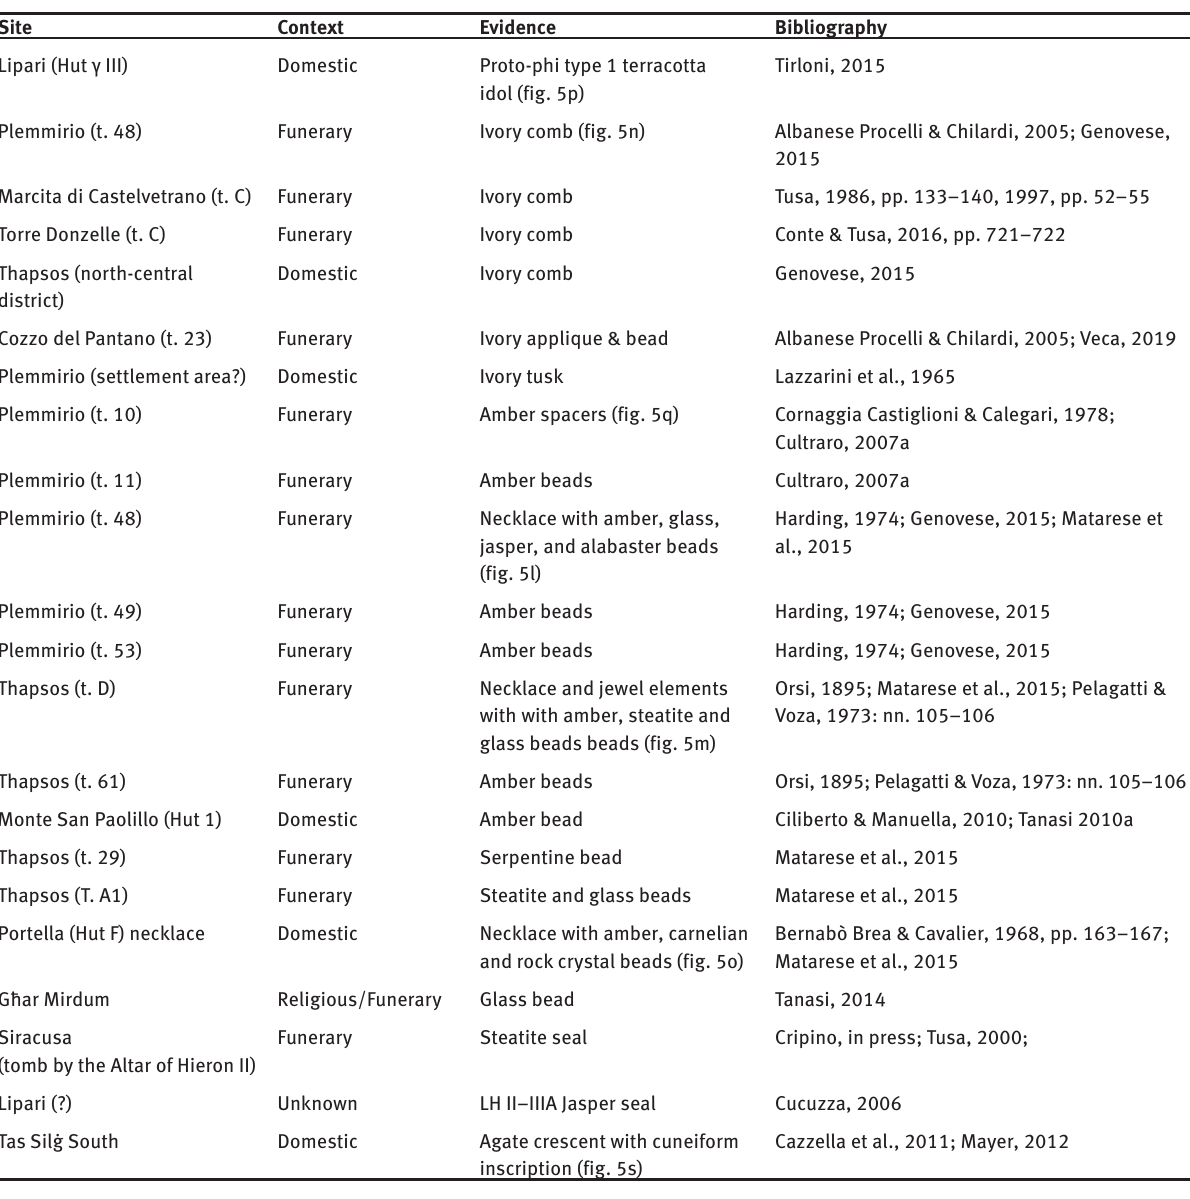
Table 5: Terracotta and Luxury Artefacts of Mycenaean Origin in Middle Bronze Age Sicily and Malta.